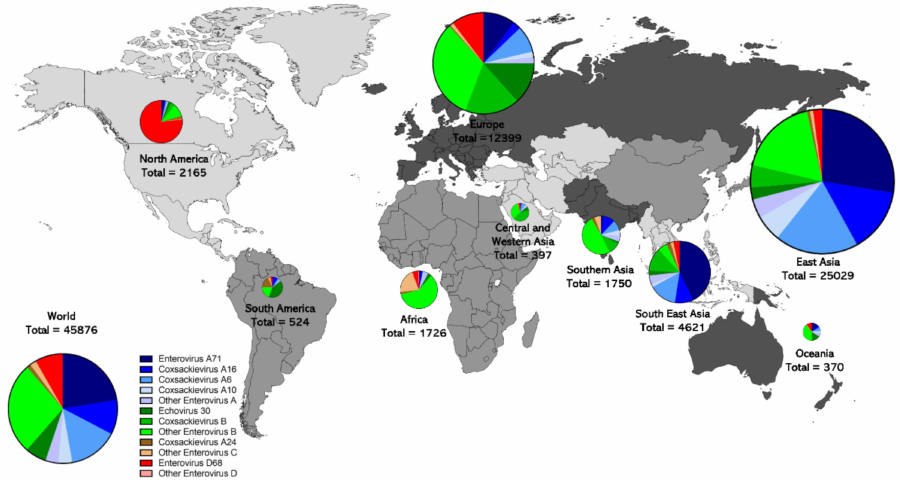
Figure 3. Geographic distribution of non-polio enterovirus genomic sequence records. The origin (if available) of all non-polio enterovirus A (blue) B (green) C (brown) and D (red) sequences from samples collected from 2000 to 2018 are shown, highlighting the di ff erent distribution patterns